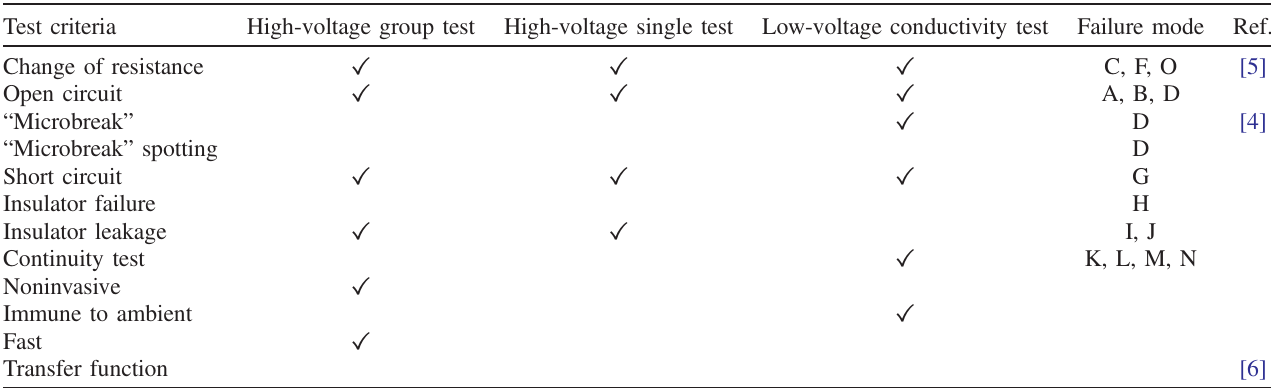
TABLE I. The summary of resistor and insulation components failure modes and diagnostic techniques used in